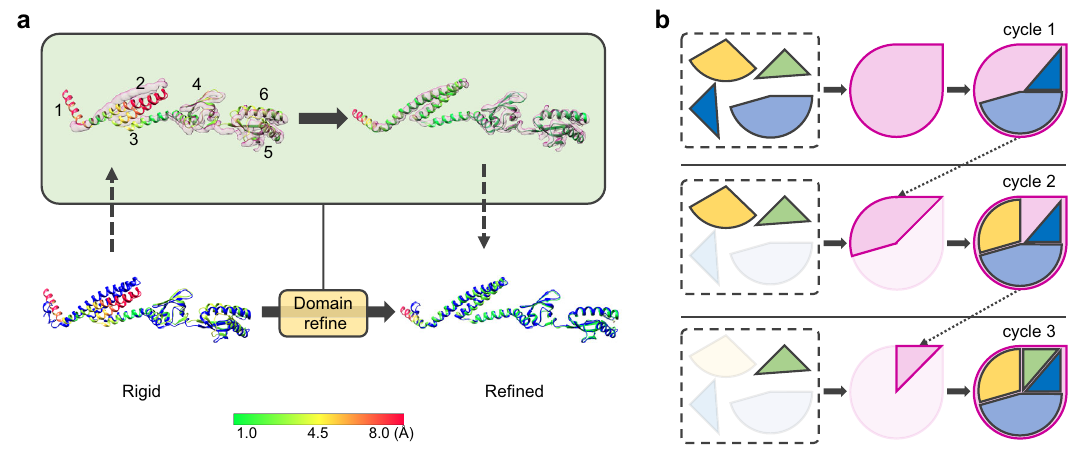
Fig. 2 Detailed illustration of iterative fl exible fi tting. a Schematic of the domain re fi nement procedure applied in EMBuild. The main-chain probability map is in transparent magenta, the reference PDB structure is in blue, and the fi tted query model is colored from green to red according to the C α displacements between the query model and the PDB structure. Owing to the conformational deviation between the query model and the PDB structure, the query chain matches poorly to the reference structure as a rigid entirety (bottom left). For better fi tting, the query chain is then split into multiple domains, as indicated by numbers 1 – 6 (top left). At last, all domains are iteratively optimized to achieve their best fi tting into the main-chain probability map (top right). As such, the fi nal fi tted model shows good consistency with the PDB structure (bottom right). b The iterative building strategy adopted by EMBuild. After each cycle of building, the map regions with fi tted structures are removed from further fi tting. The remaining chains are iteratively assembled to the complex under the guidance of the updated main-chain probability